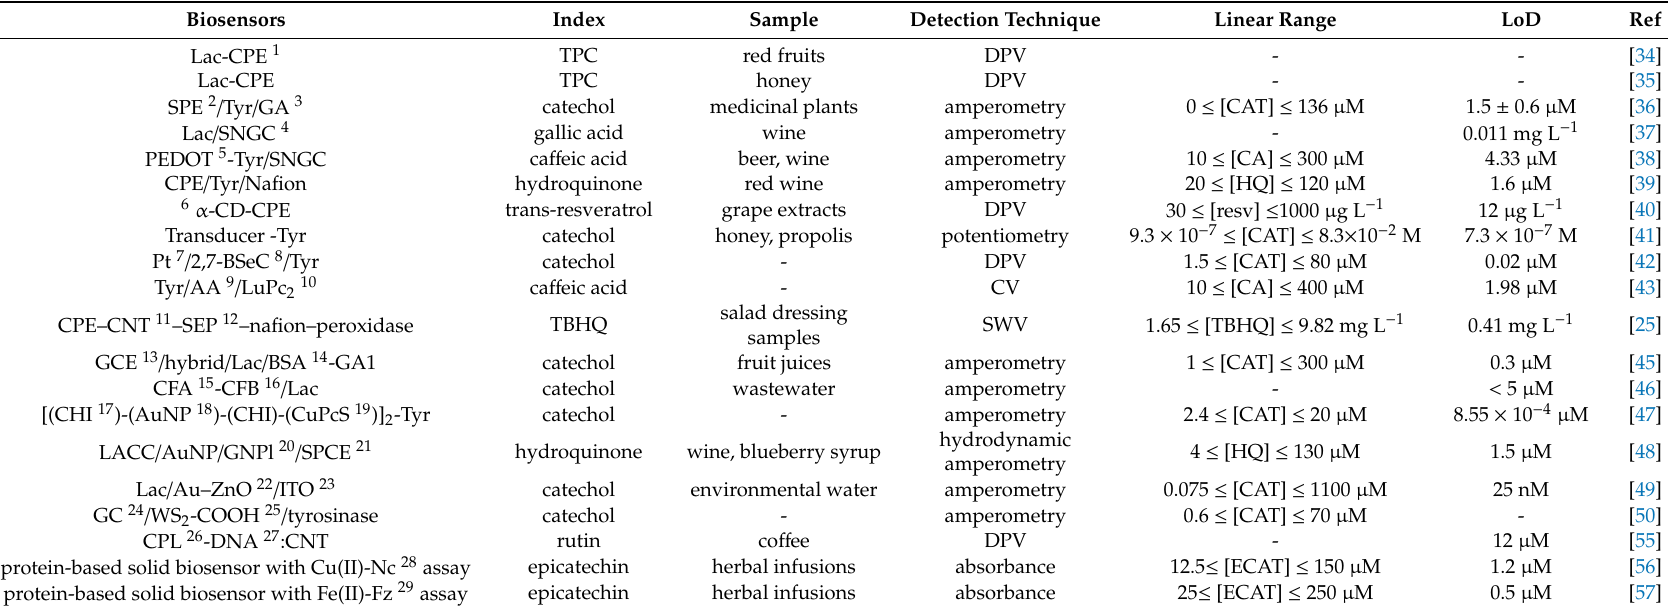
Table 1. Partial applications of various biosensor architectures for the detection of phenolic